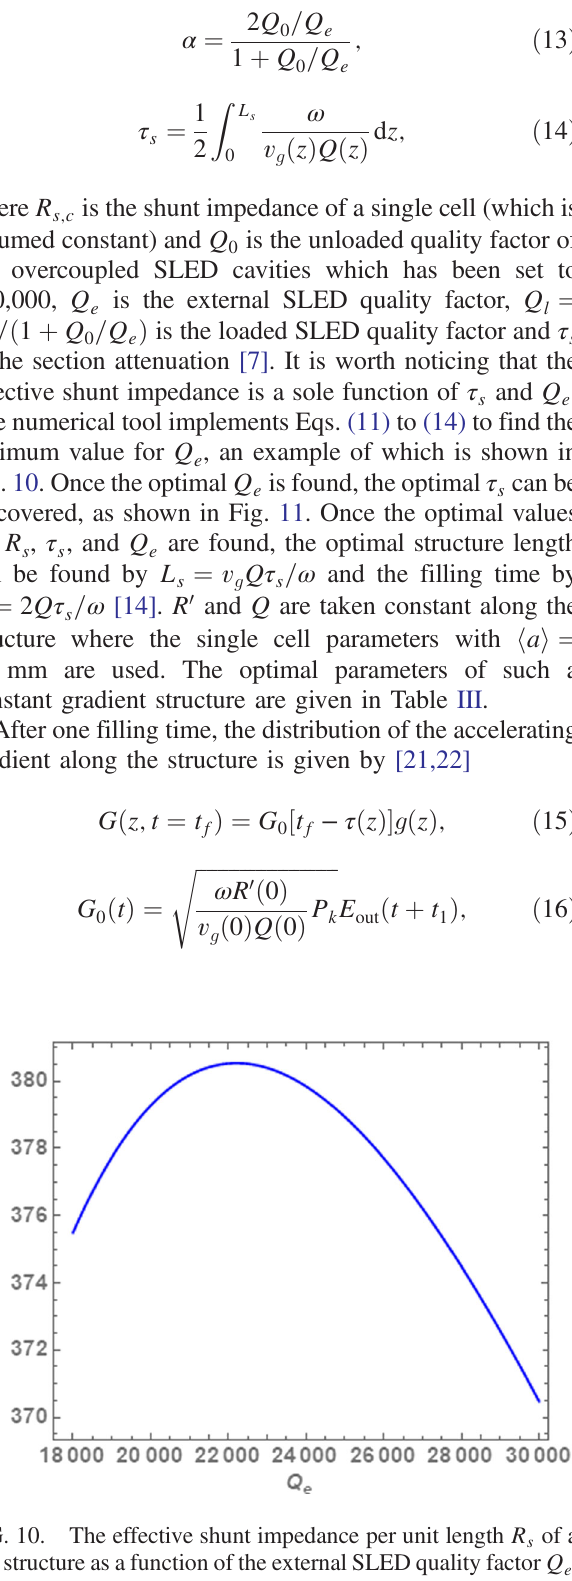
FIG. 10. The effective shunt impedance per unit length R CG structure as a function of the external SLED quality factor Q